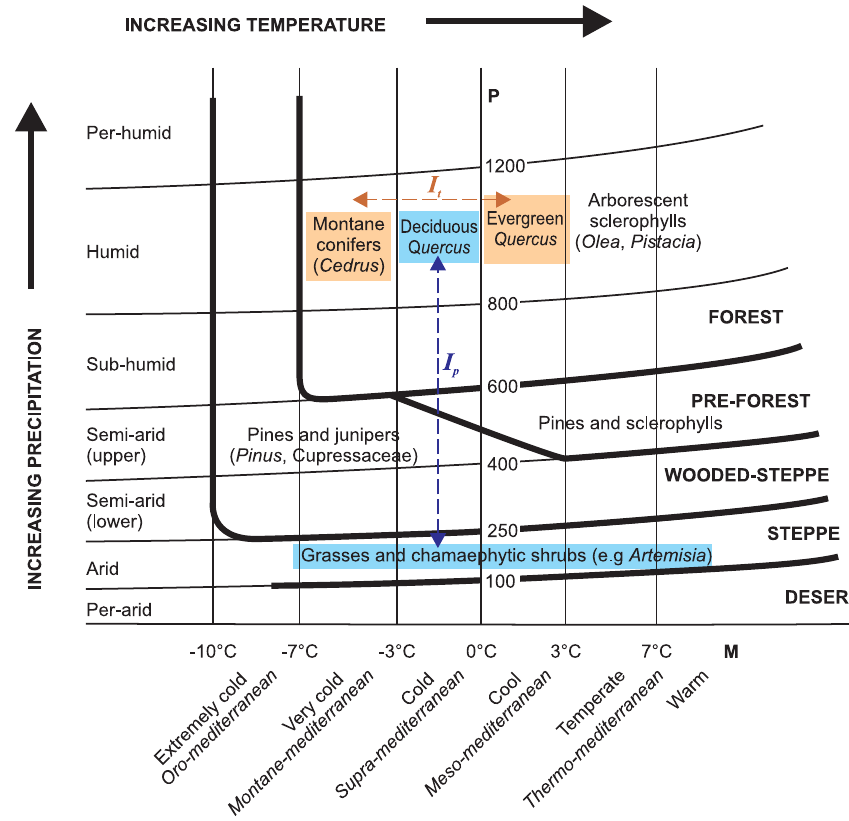
Fig. 2. Schematic diagram showing the distribution of vegetation types in the Alboran borderlands with respect to climatic gradients P (annual precipitation) and M (average maximum temperature of the coldest month of the year) adapted from Quezel (2002). The distribution in climatic space of select vegetation types which are well-represented in the pollen record (deciduous Quercus , evergreen Quercus , montane conifers and semi-desert plants) provides the conceptual basis for the construction of the pollen indices I t and I p